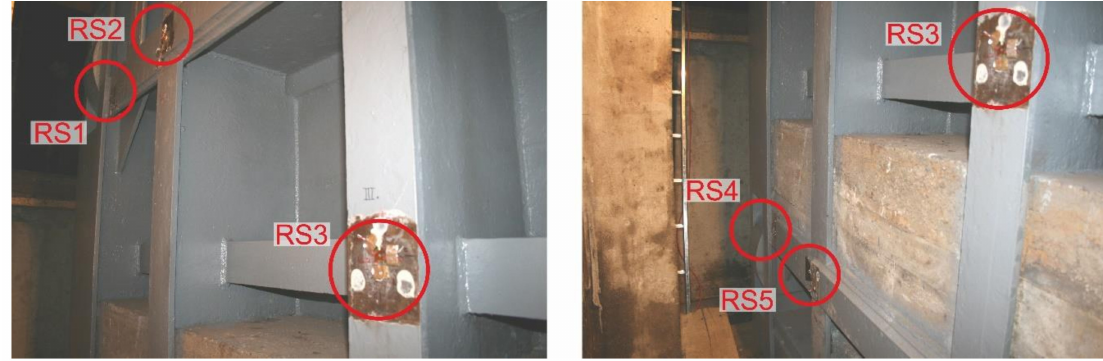
Figure 10. Position of strain gauge rosettes on the sluice gate.